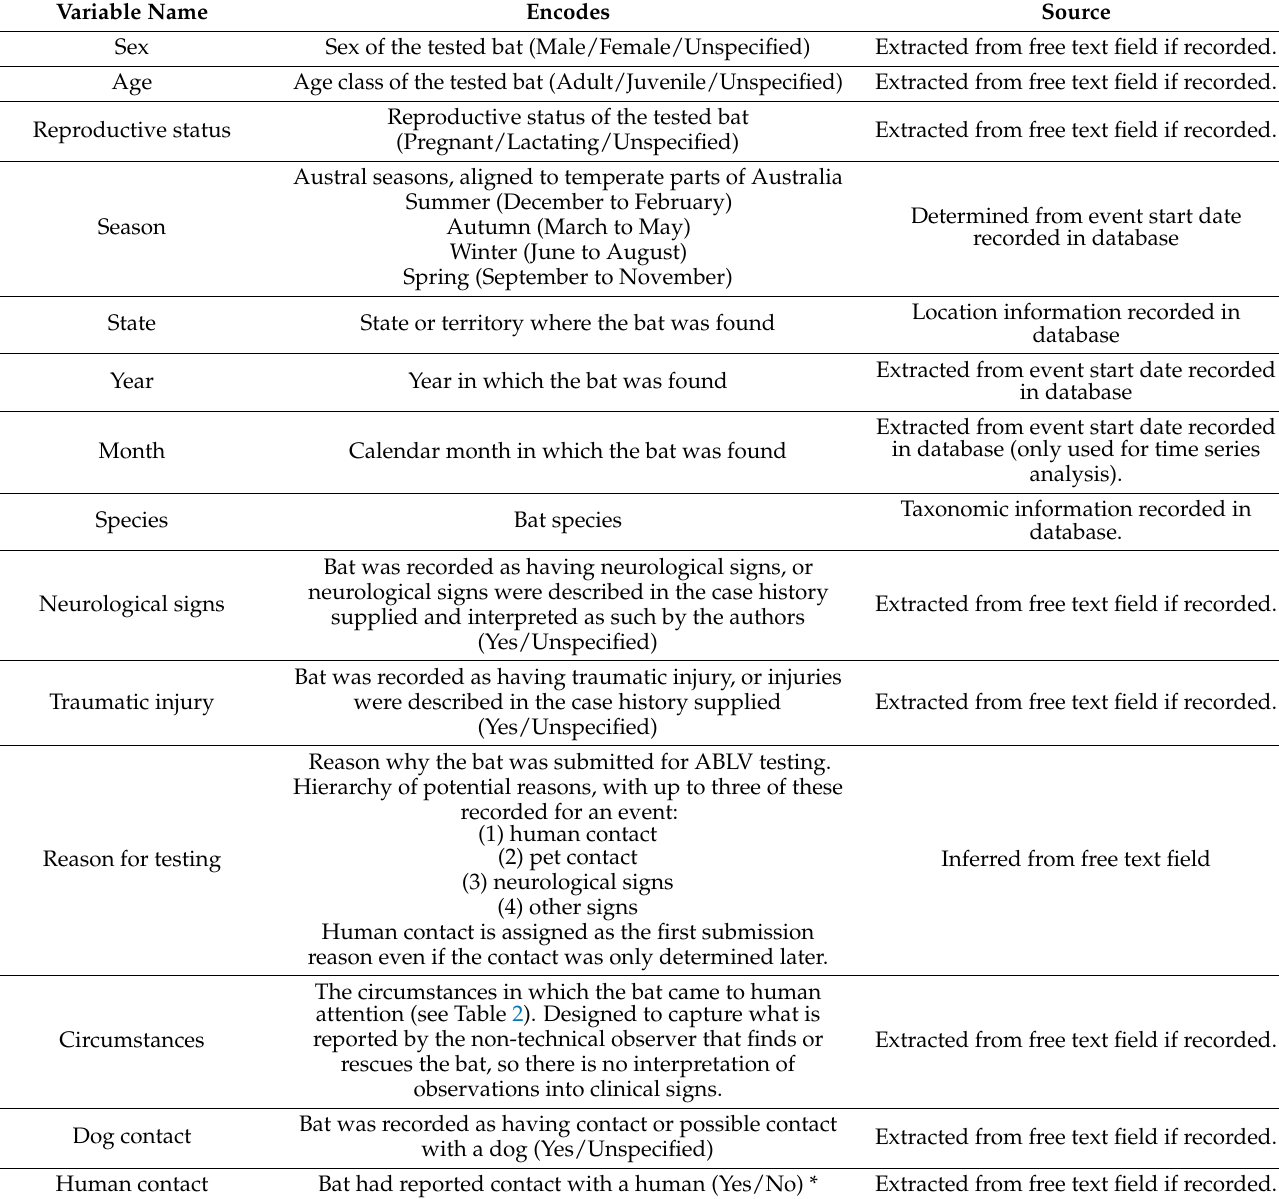
Table 1. Variables used for this analysis.